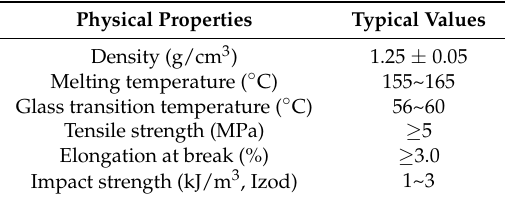
Table 1. Typical values of PLA’s physical